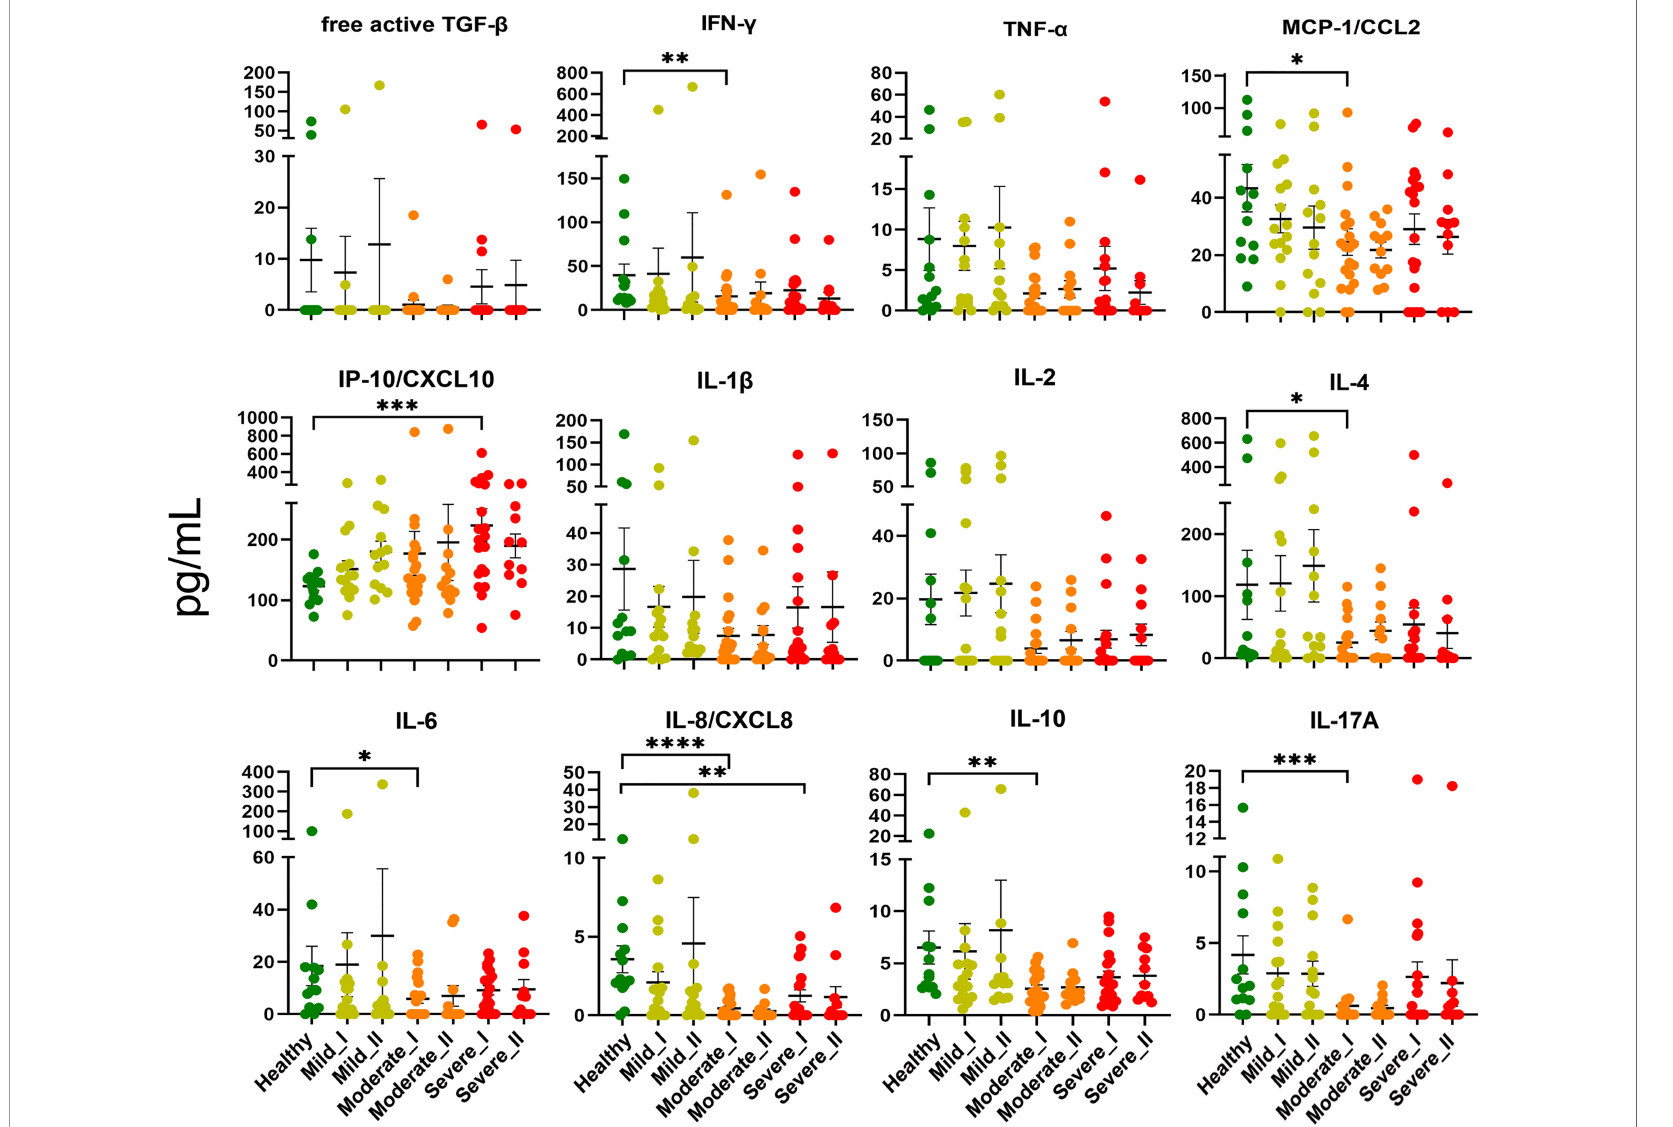
FIGURE 2 | Plasma level of cytokines and chemokines from COVID-19 convalescents and controls. Quanti fi cation of cytokines and other mediators in plasma obtained from COVID-19 convalescents after severe (time-point I, n=20, time-point II, n=11), moderate (time-point I, n=20, time-point II, n=12) and mild disease (time-point I, n = 15, time-point II, n=13) at two time points after disease con fi rmation and from healthy controls (n = 13). Data represent individual values, mean (centre bar) ± SD (upper and lower bars). Statistical analysis by one-way ANOVA test, *p ≤ 0,05; **p ≤ 0,01; ***p ≤ 0,001; ****p ≤